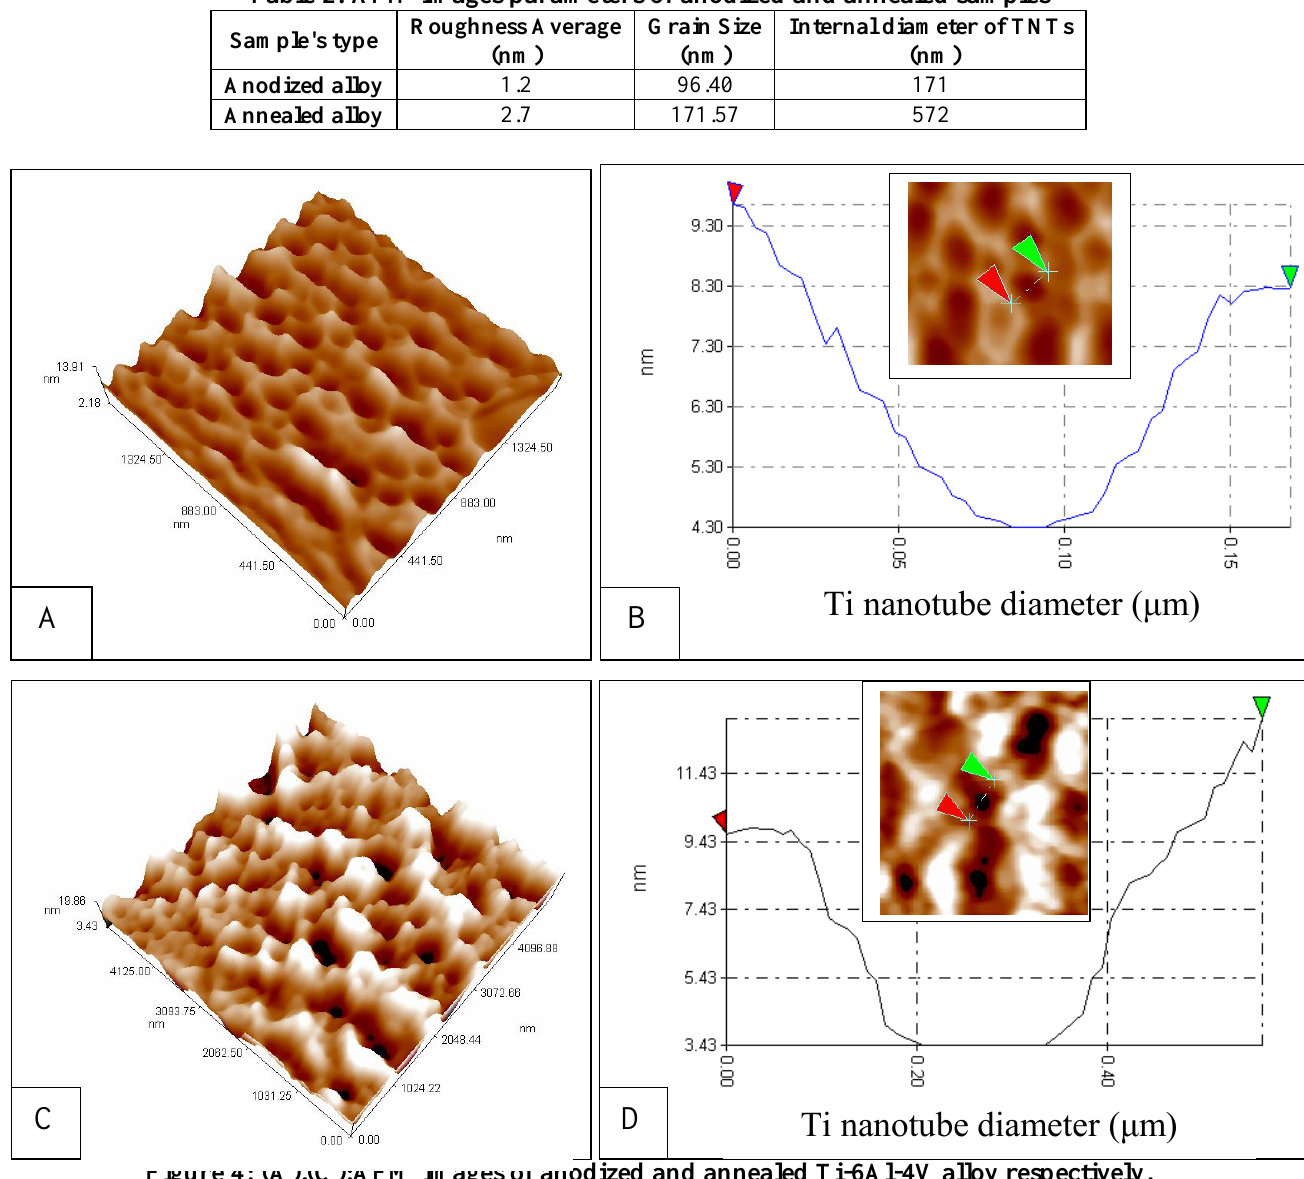
Table 2: AFM images parameters of anodized and annealed samples